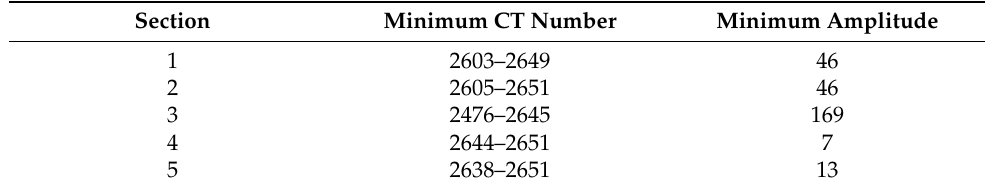
Table 2. The minimum CT numbers in the